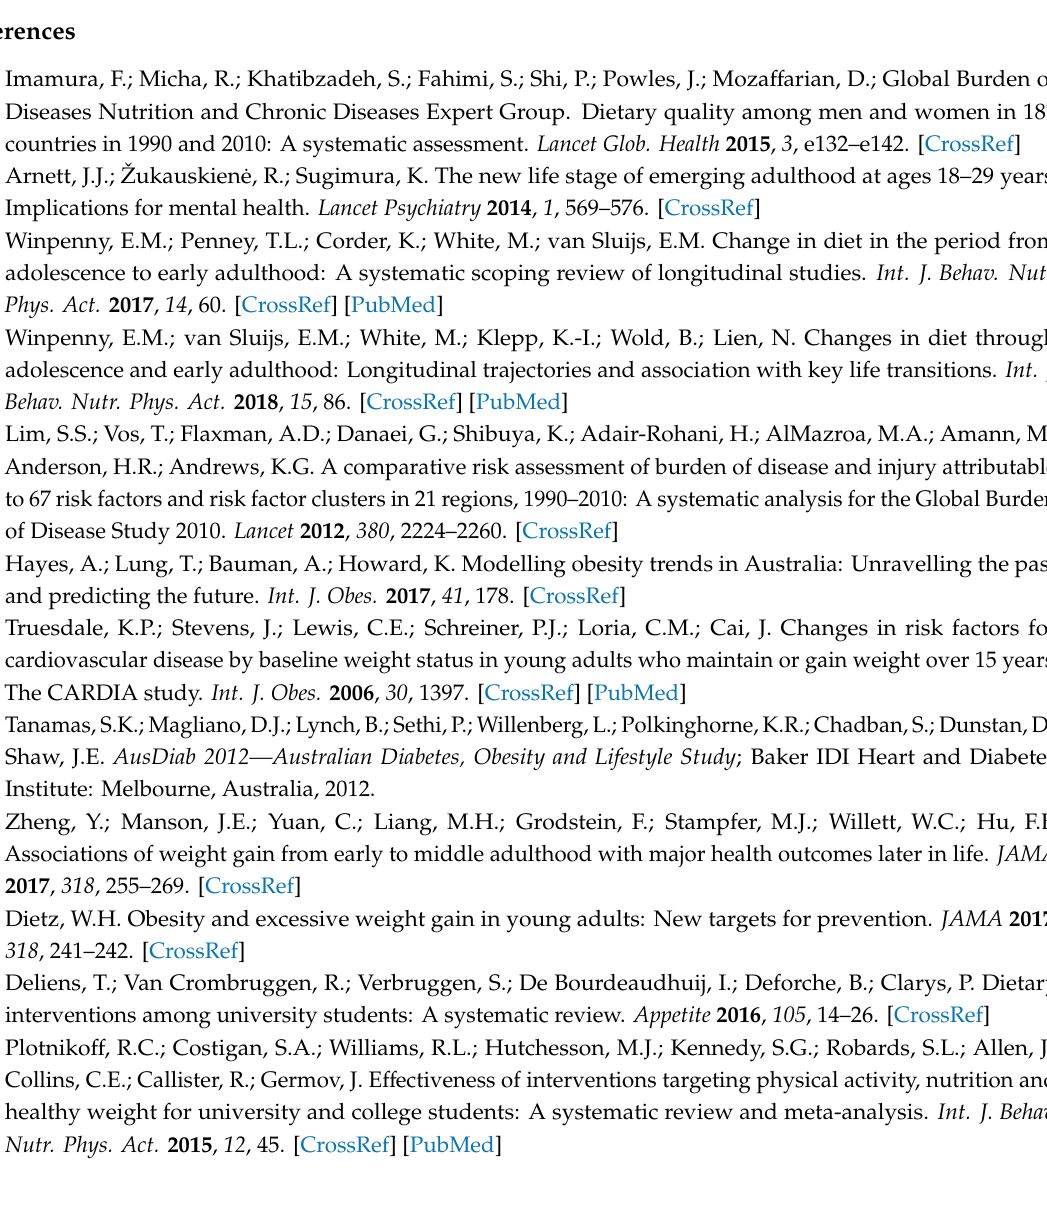
Figure S1: Funnel Plot TEI, Figure S2: Plots of the means for e ff ects TEI, Figure S3: Model Diagnostics TEI, Figure S4: forest plot TEI, Figure S5: Funnel Plot F&V, Figure S6: Plots of the means for e ff ects F&V, Figure S7: Model Diagnostics F&V, Figure S8: forest plot F&V. Table S1: Final search by database, Table S2: Summary of included